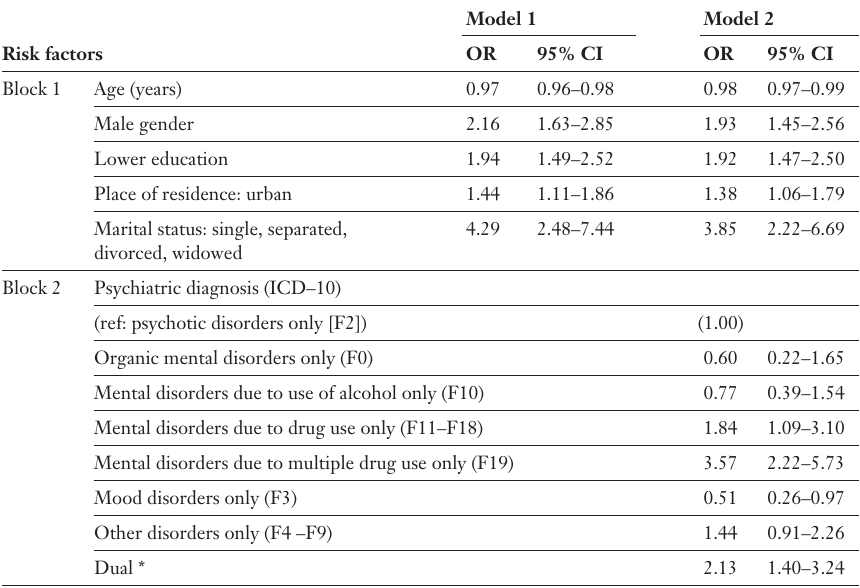
Risk factors of home- lessness in psychi- atric